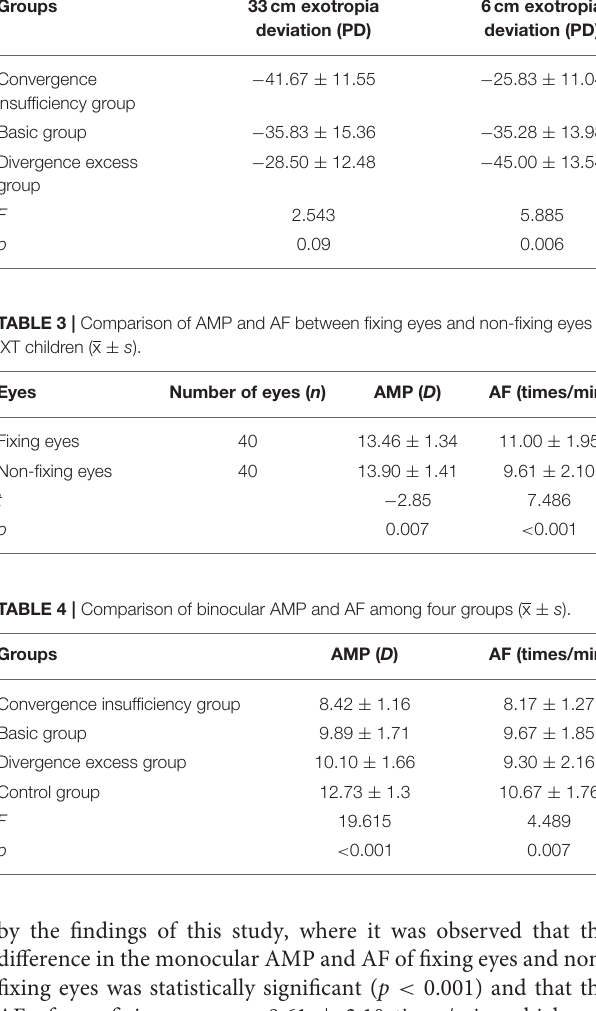
TABLE 2 | Comparison of far and near exotropia deviation of intermittent exotropia among three groups (x ± s ). Groups